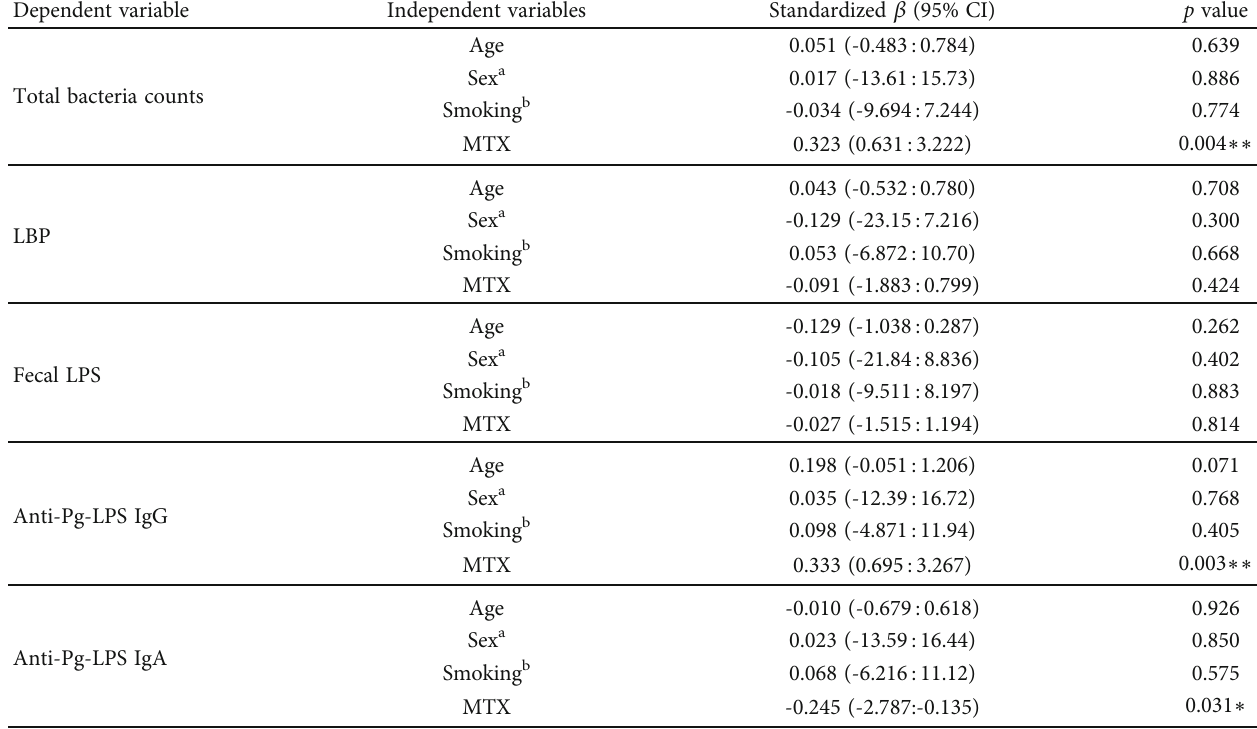
Table 7: Multiple regression analysis between bacteria-related markers and demographic factors.